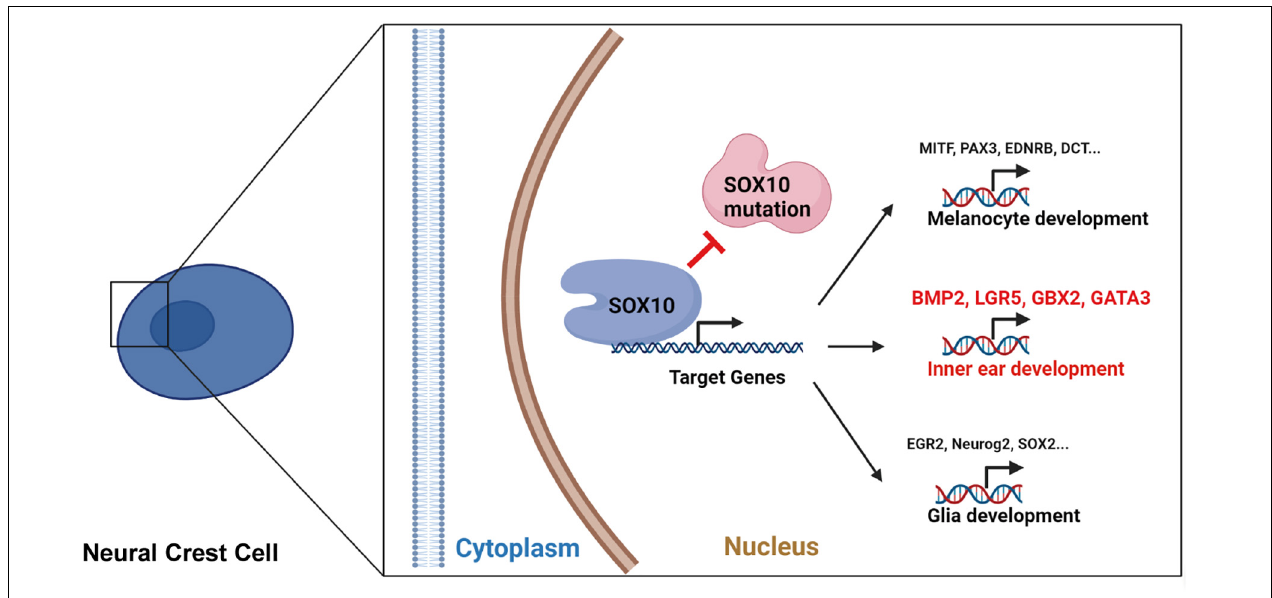
FIGURE 10 | The schematic diagram for the SOX10 -regulated transcription of certain target genes during development and differentiation in neural crest cell.